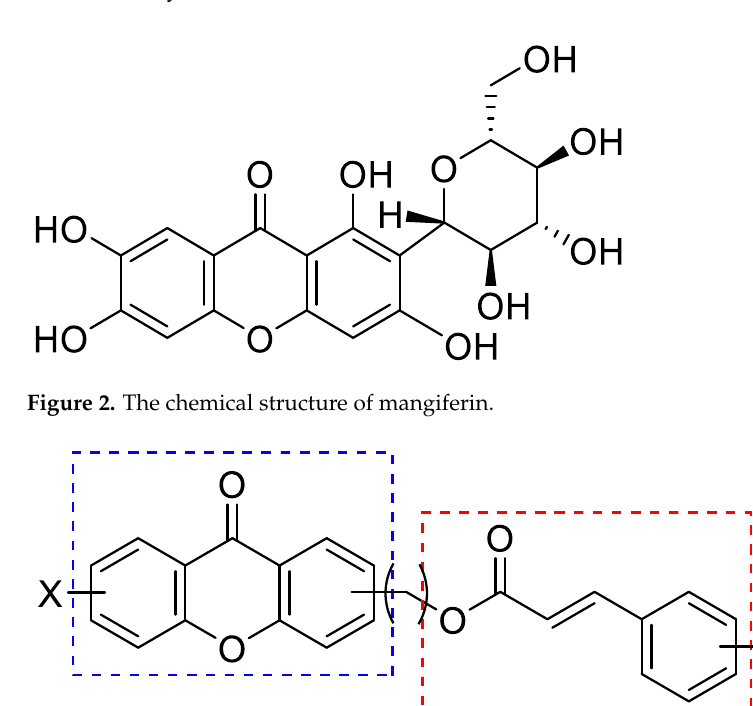
Figure 2. The chemical structure of mangiferin.